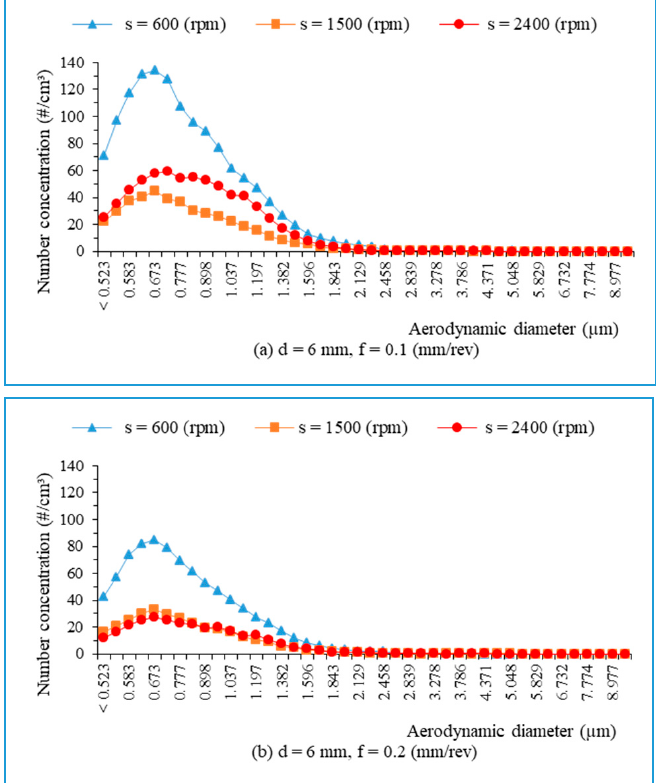
Figure 15. The number of fine particles versus aerodynamic diameters during drilling, with a drill of 6 mm: ( a ) f = 0.1 mm/rev; and ( b ) f = 0.2 mm/rev.